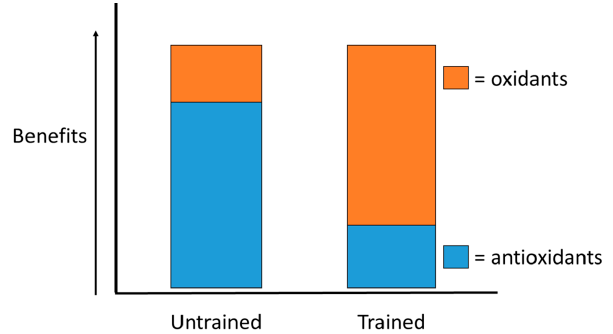
Figure 3. Balance between antioxidants and oxidants in untrained and trained individuals in as